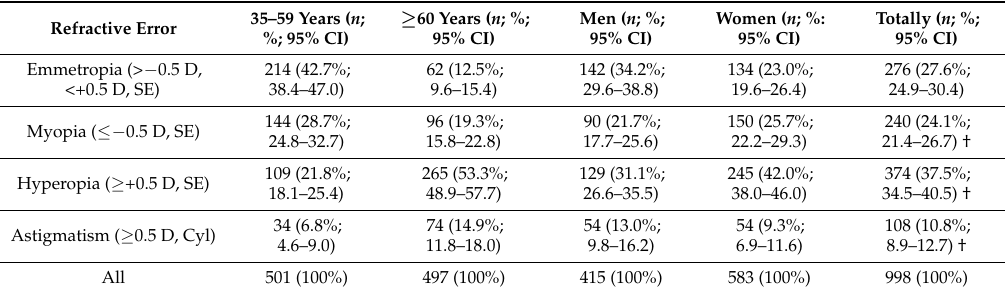
Table 2. Distribution of refractive errors in a researched group.